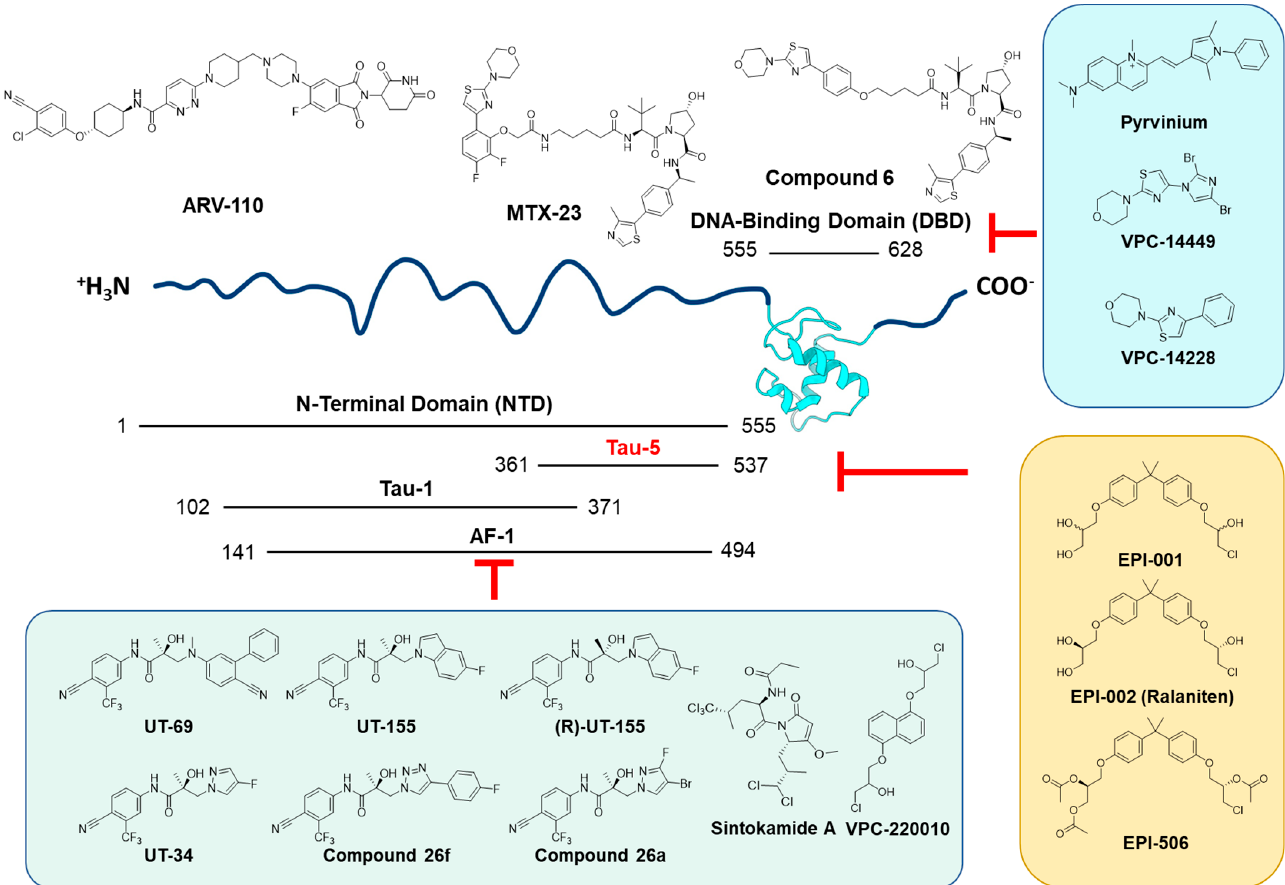
Figure 5. Schematic illustration of androgen receptor splice variant from N-terminal domain to C-terminal. Compounds that inhibit the AF-1 region of NTD domain are listed in the lower left hand green highlighted frame, compounds that inhibit the Tau-5 region of the NTD are listed in the yellow highlighted frame, and compounds inhibiting the DBD are listed in the upper right blue highlighted frame. Two reported PROTAC molecules based on DBD inhibitors are shown on the top of the figure.